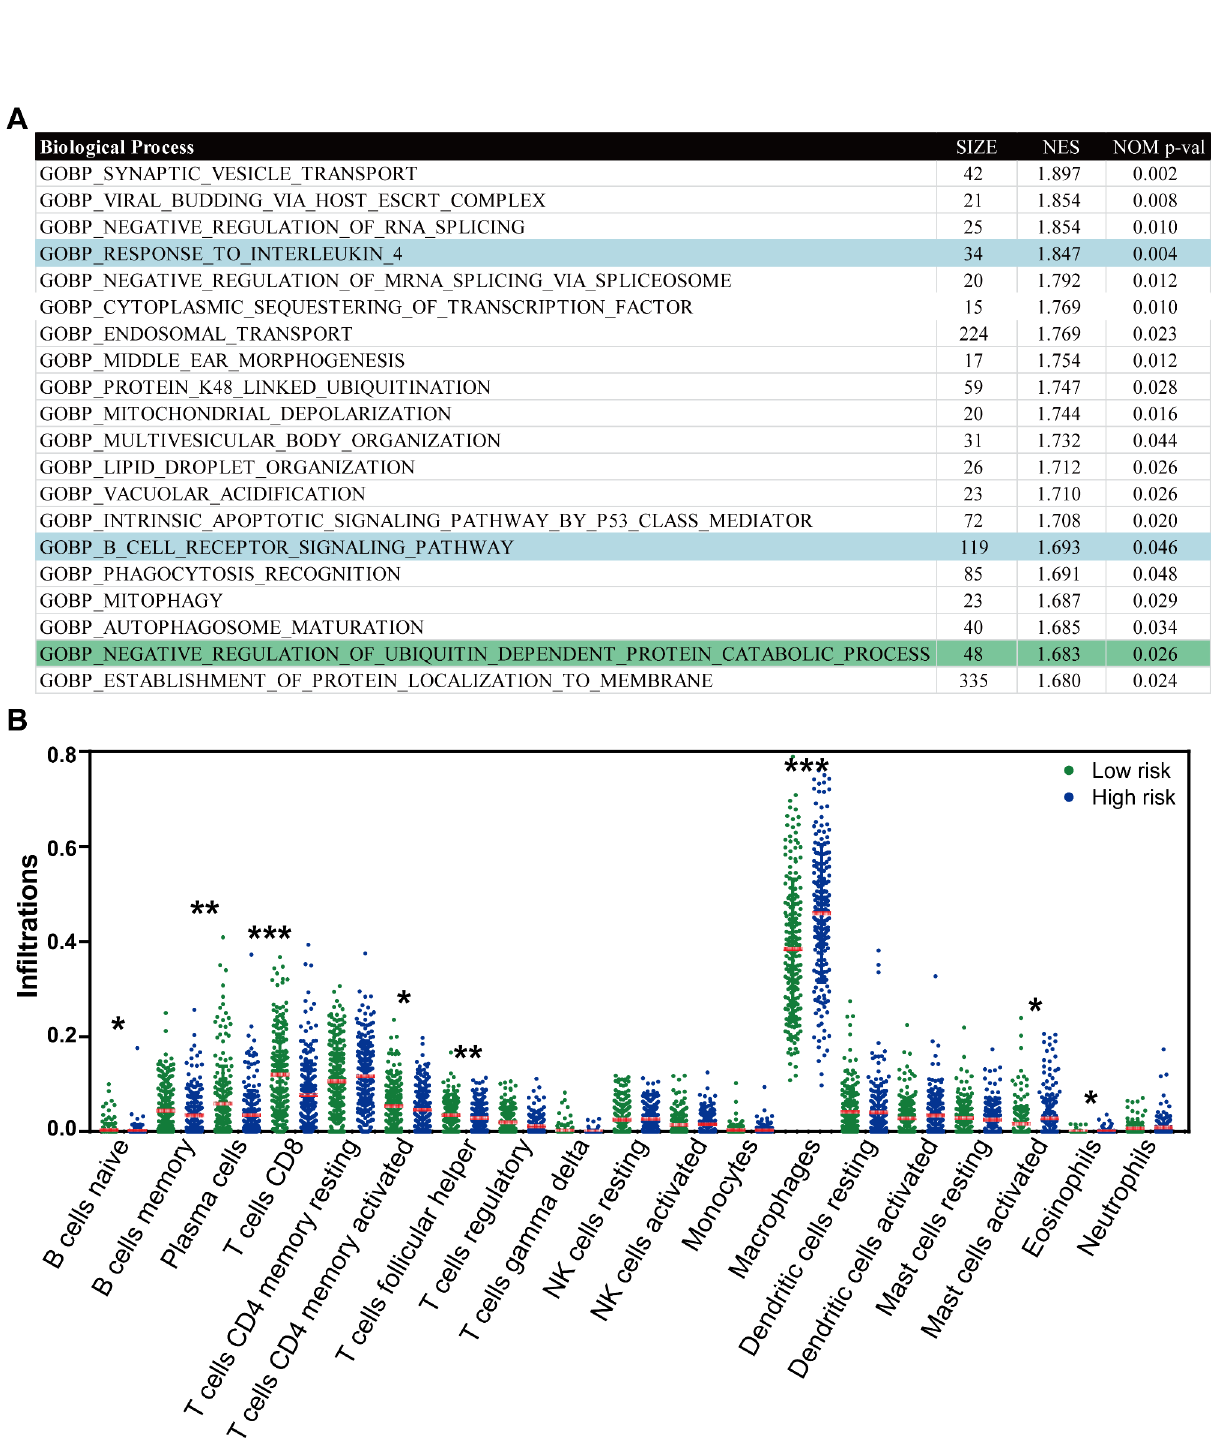
Fig. 6 The ERS-related signature is an independent prognostic factor in HNSCC patients. Univariate ( A ) and multivariate ( B ) Cox regression of prognosis factor for OS of HNSCC patients. ( C ) Kaplan–Meier analysis of OS for HNSCC patients stratified by sex, age, ethnicity, T, stage, grade, cancer status and lymphnode neck dissection